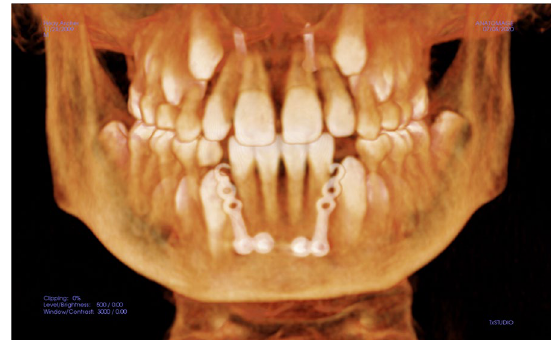
Fig. 2 L-plate with two screws placed bilaterally apical to the lower incisors, to avoid the developing mandibular canine